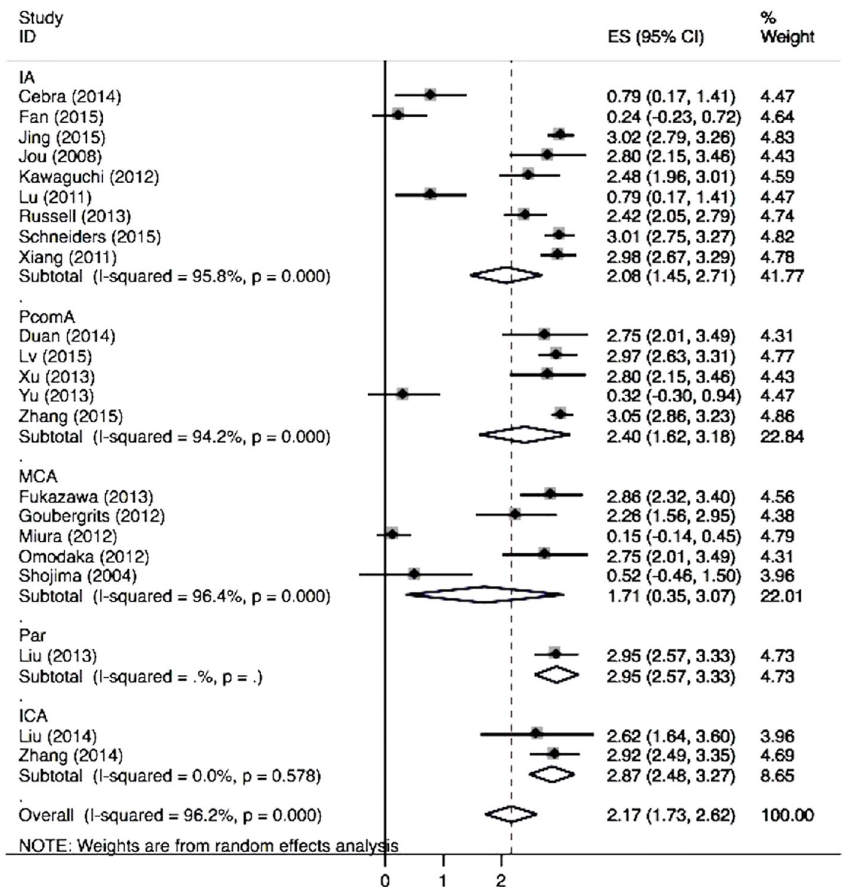
Figure 2. Forest plot of low WSS rate stratified by the location of aneurysm.